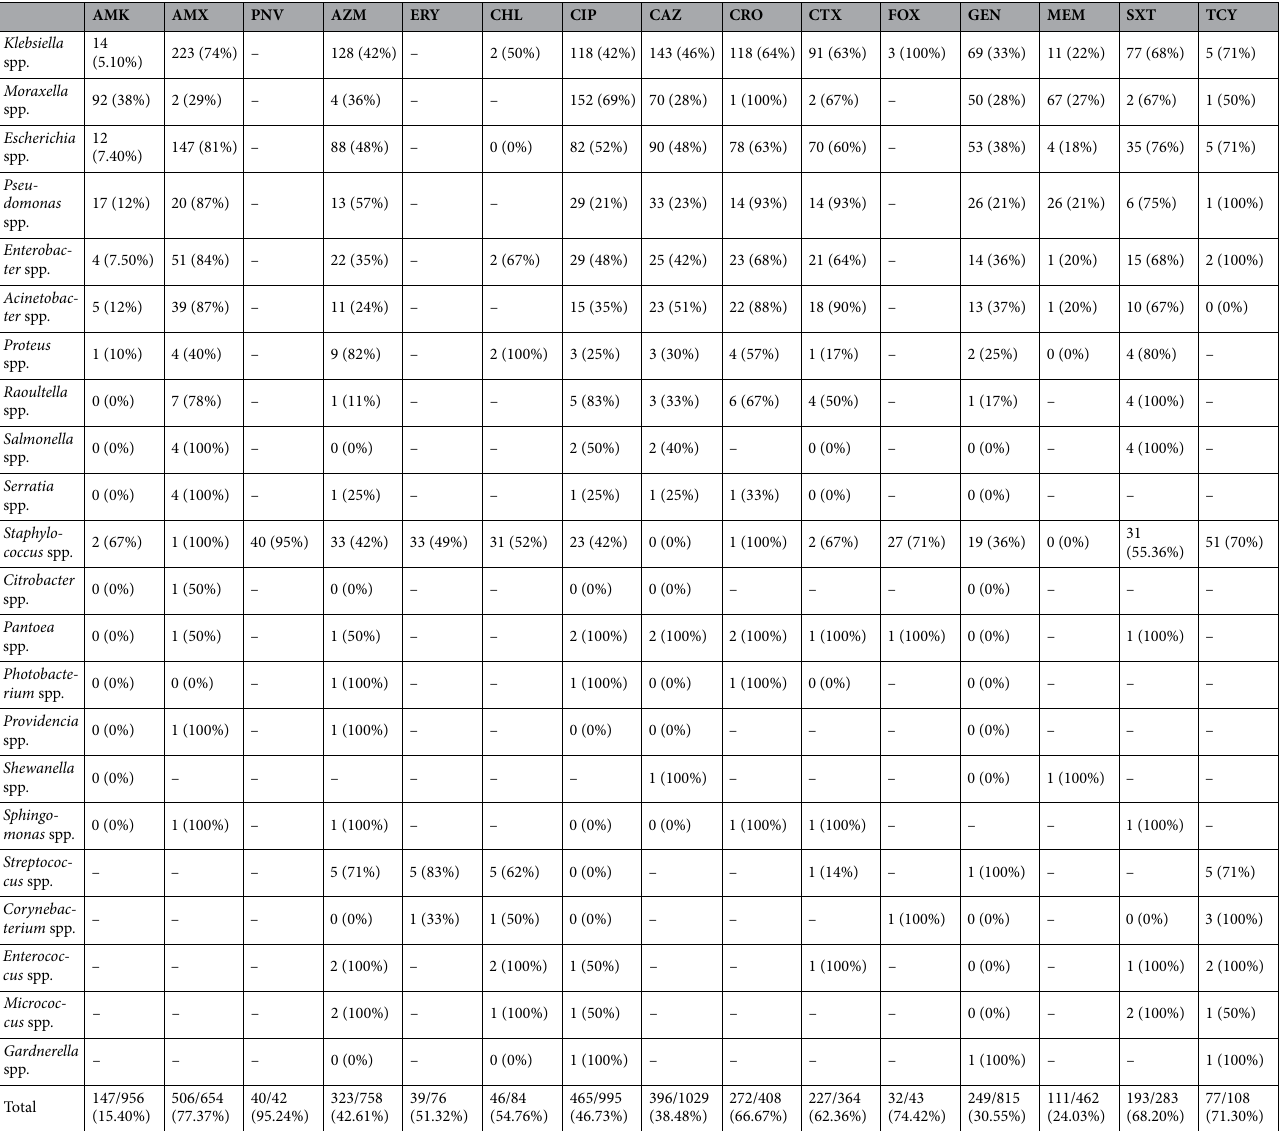
Table 3. Antibiotic resistance profile of bacteria isolated at the TZPHRL. AMK Amikacin, AMX Amoxicillin, AZM Azithromycin, CAZ Ceftazidime, CHL Chloramphenicol, CIP Ciprofloxacin, CRO Ceftriaxone, CTX Cefotaxime, ERY Erythromycin, FOX Cefoxitin, GEN Gentamicin, MEM Meropenem, PNV Penicillin V, SXT Trimethoprim/Sulfamethoxazole, TCY